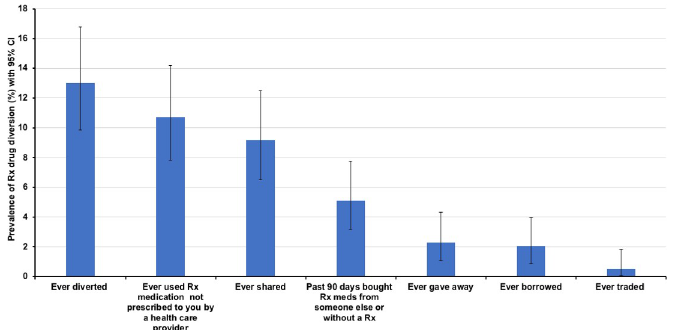
Fig 1. The prevalence of diversion and types of prescription drug diversion, with a 95% confidence interval reported by people living with HIV in the eThekwini district.